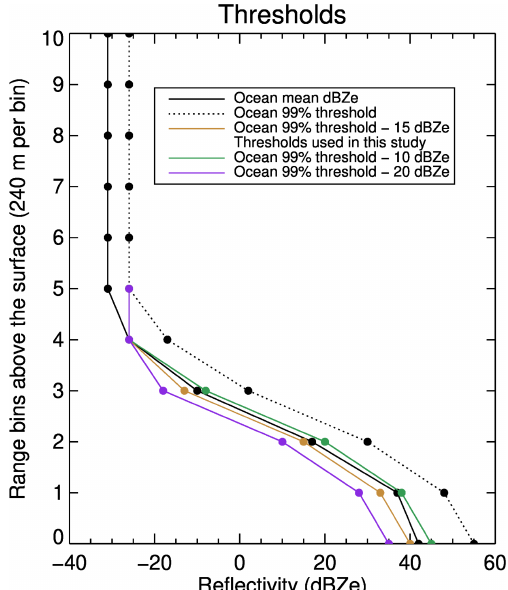
Figure 2. Typical (estimated) surface clutter profile adapted from Fig. 7 in Marchand et al. (2008) and thresholds used (blue line) in this study to detect clouds for